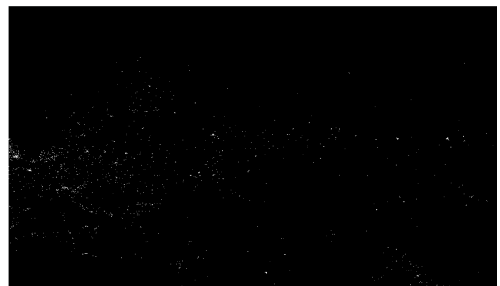
Figure 5. The urban part of the global land cover map